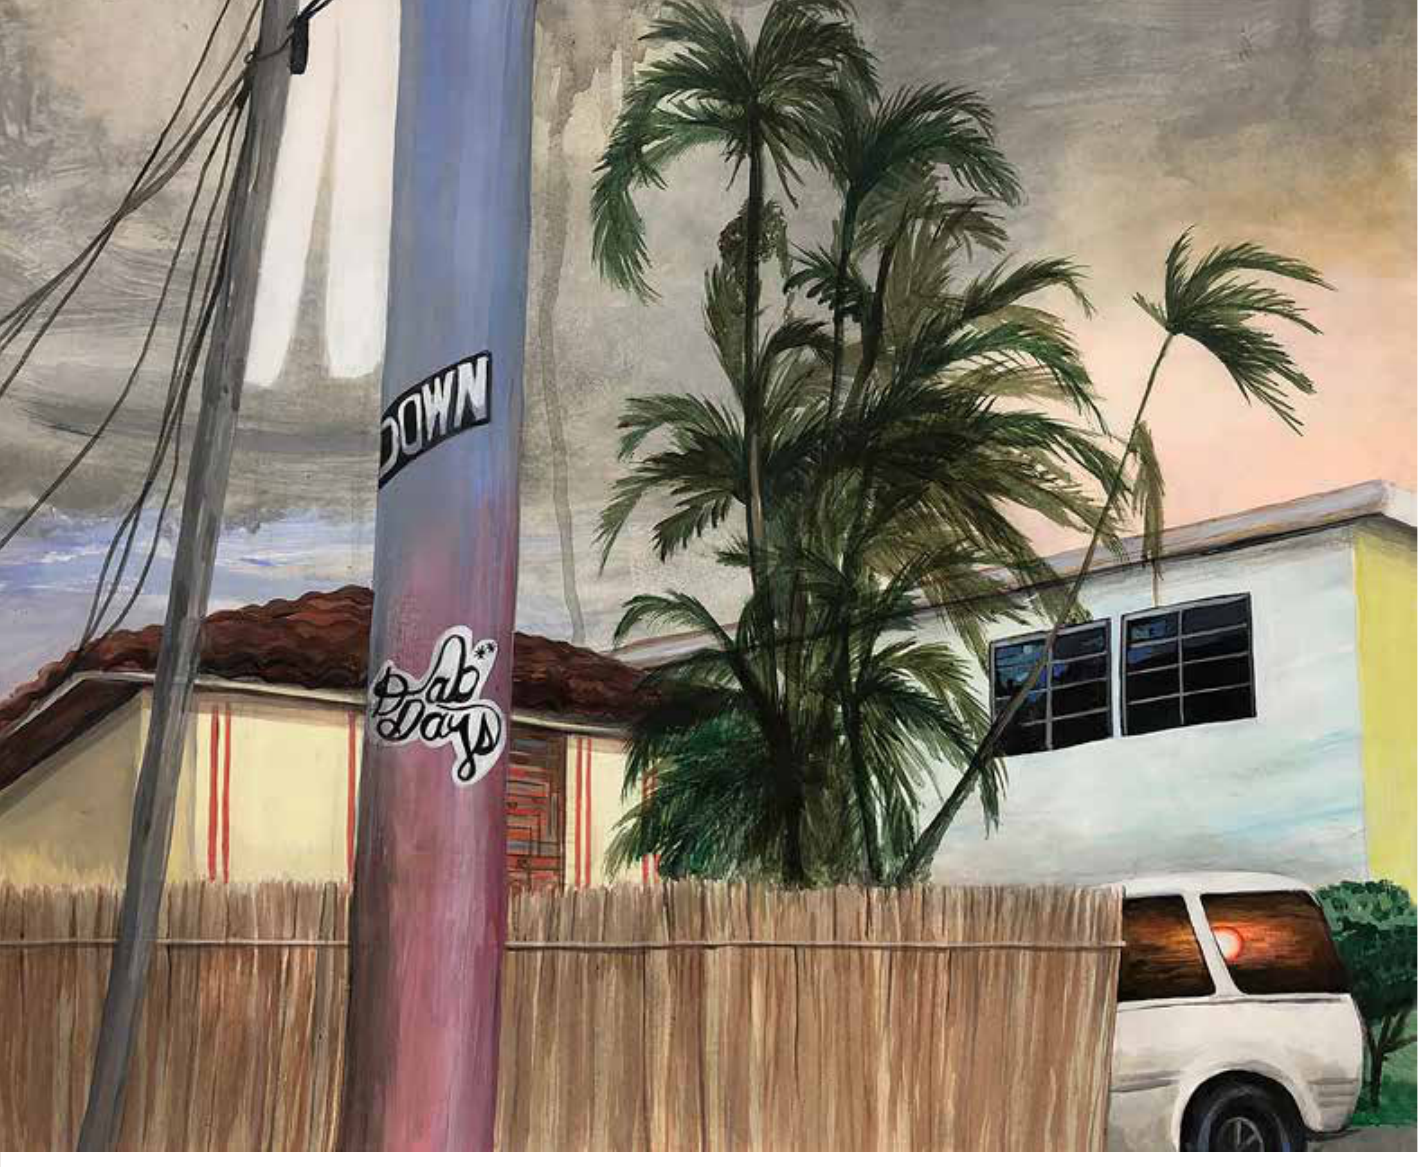
Figure 2 (previous page, top): Denise Burge, Holiday Sands, 2019. Acrylic on paper, 25.4 x 25.4 cm. Figure 3 (previous page, bottom): Denise Burge, Vacancy 2, 2019. Acrylic on paper, 25.4 x 25.4 cm. Figure 4 (current): Denise Burge, Miami, 2019. Acrylic on paper, 45.7 x 50.8